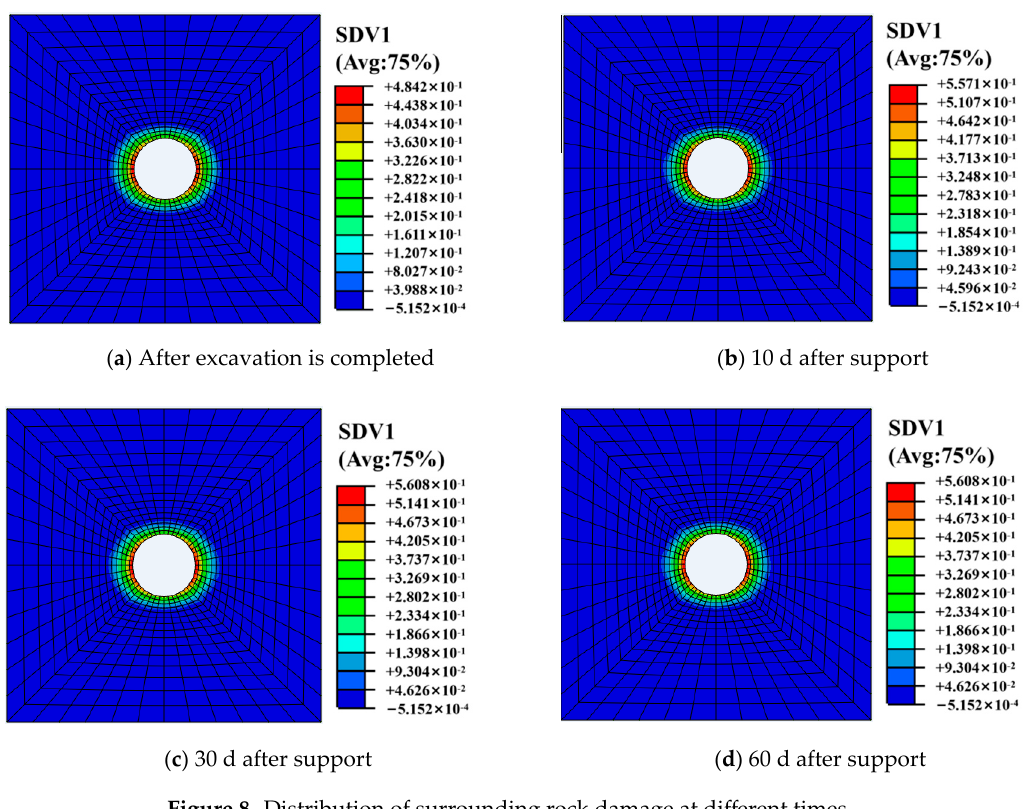
Figure 9. Distribution curve of surrounding rock damage over time.